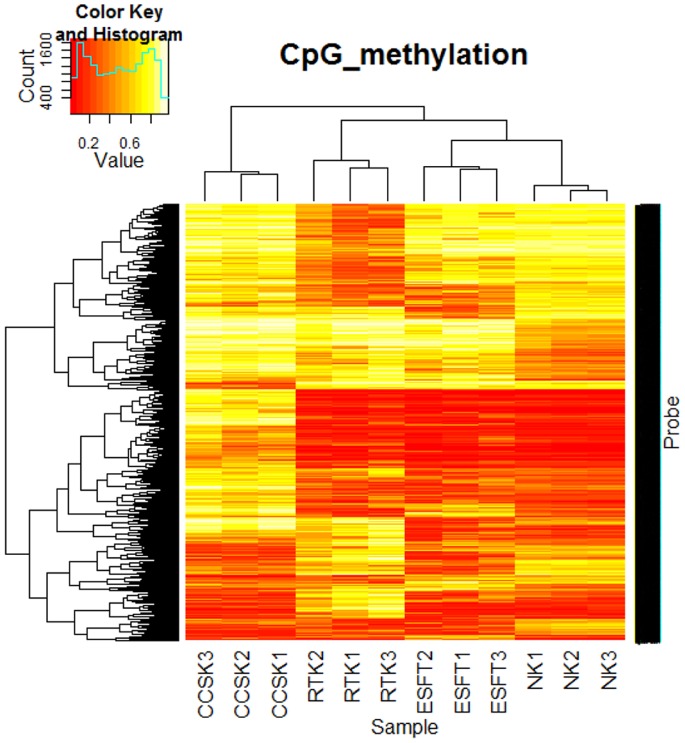
Hierarchical cluster analysis of methylation value (β) in Infinium assay on pediatric tumors.Two-way hierarchical cluster analysis of the methylation level of 1,494 probes (rows, equivalent to hyper- and hypomethylated genes shown in Table 2) and three cases for each of clear cell sarcoma of the kidney (CCSK), rhabdoid tumor of the kidney (RTK), the Ewing’s sarcoma family of tumors (ESFT), and non-neoplastic kidney (NK) (columns) were performed using hclust in the R clustering package. The β-values ranged from 0 (unmethylated) to 1 (fully methylated) on a continuous scale.